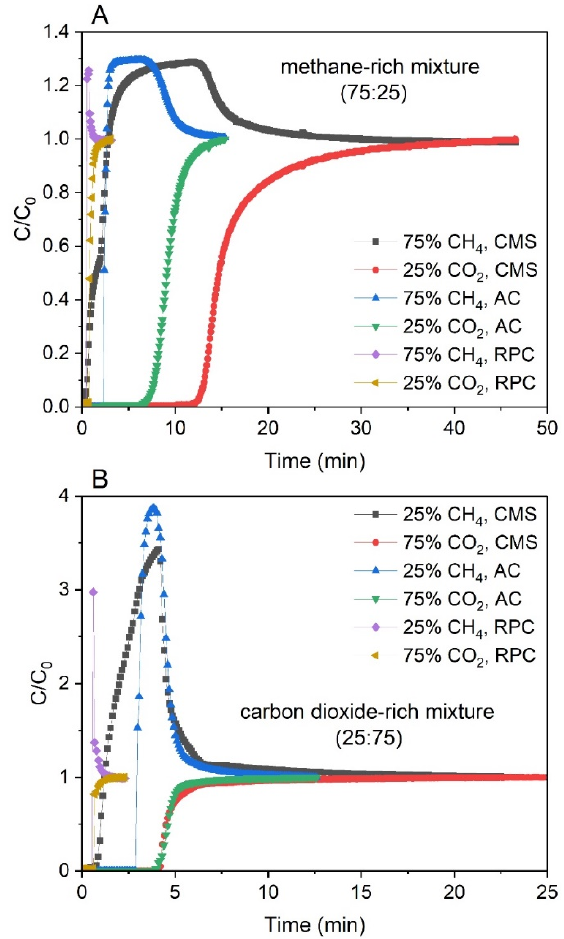
Figure 5. Breakthrough curves of CH 4 and CO 2 collected for all of the samples for the methane-rich mixture ( A ) and the carbon dioxide-rich mixture ( B ) at 1 bar and 293